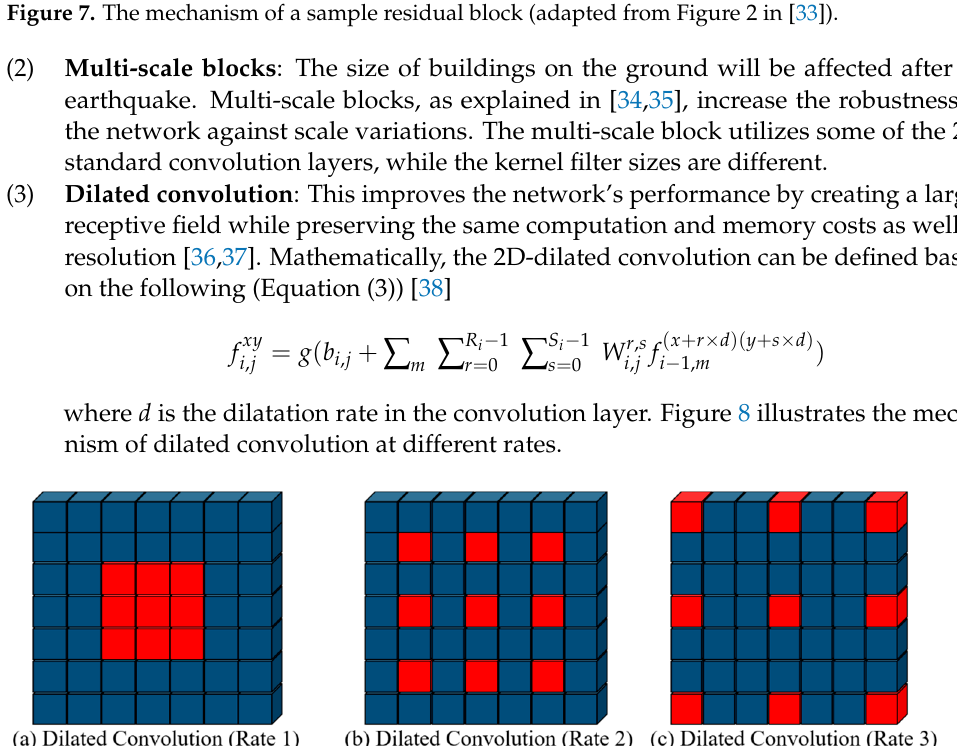
Figure 9. The main difference between standard convolution blocks and depth-wise convolution blocks. 2.3.4. Fusion Strategy All deep features for feature-level fusion are assigned to a stream. This stream com- bines extracted deep features by convolution layers from Lidar and optical datasets. At first, the extracted shallow deep features (from Lidar and Optic) from the first convolution layers are transferred to the fusion stream as the input. These features are concatenated and fed to a convolution layer in the fusion channel. Then, the output of the mentioned